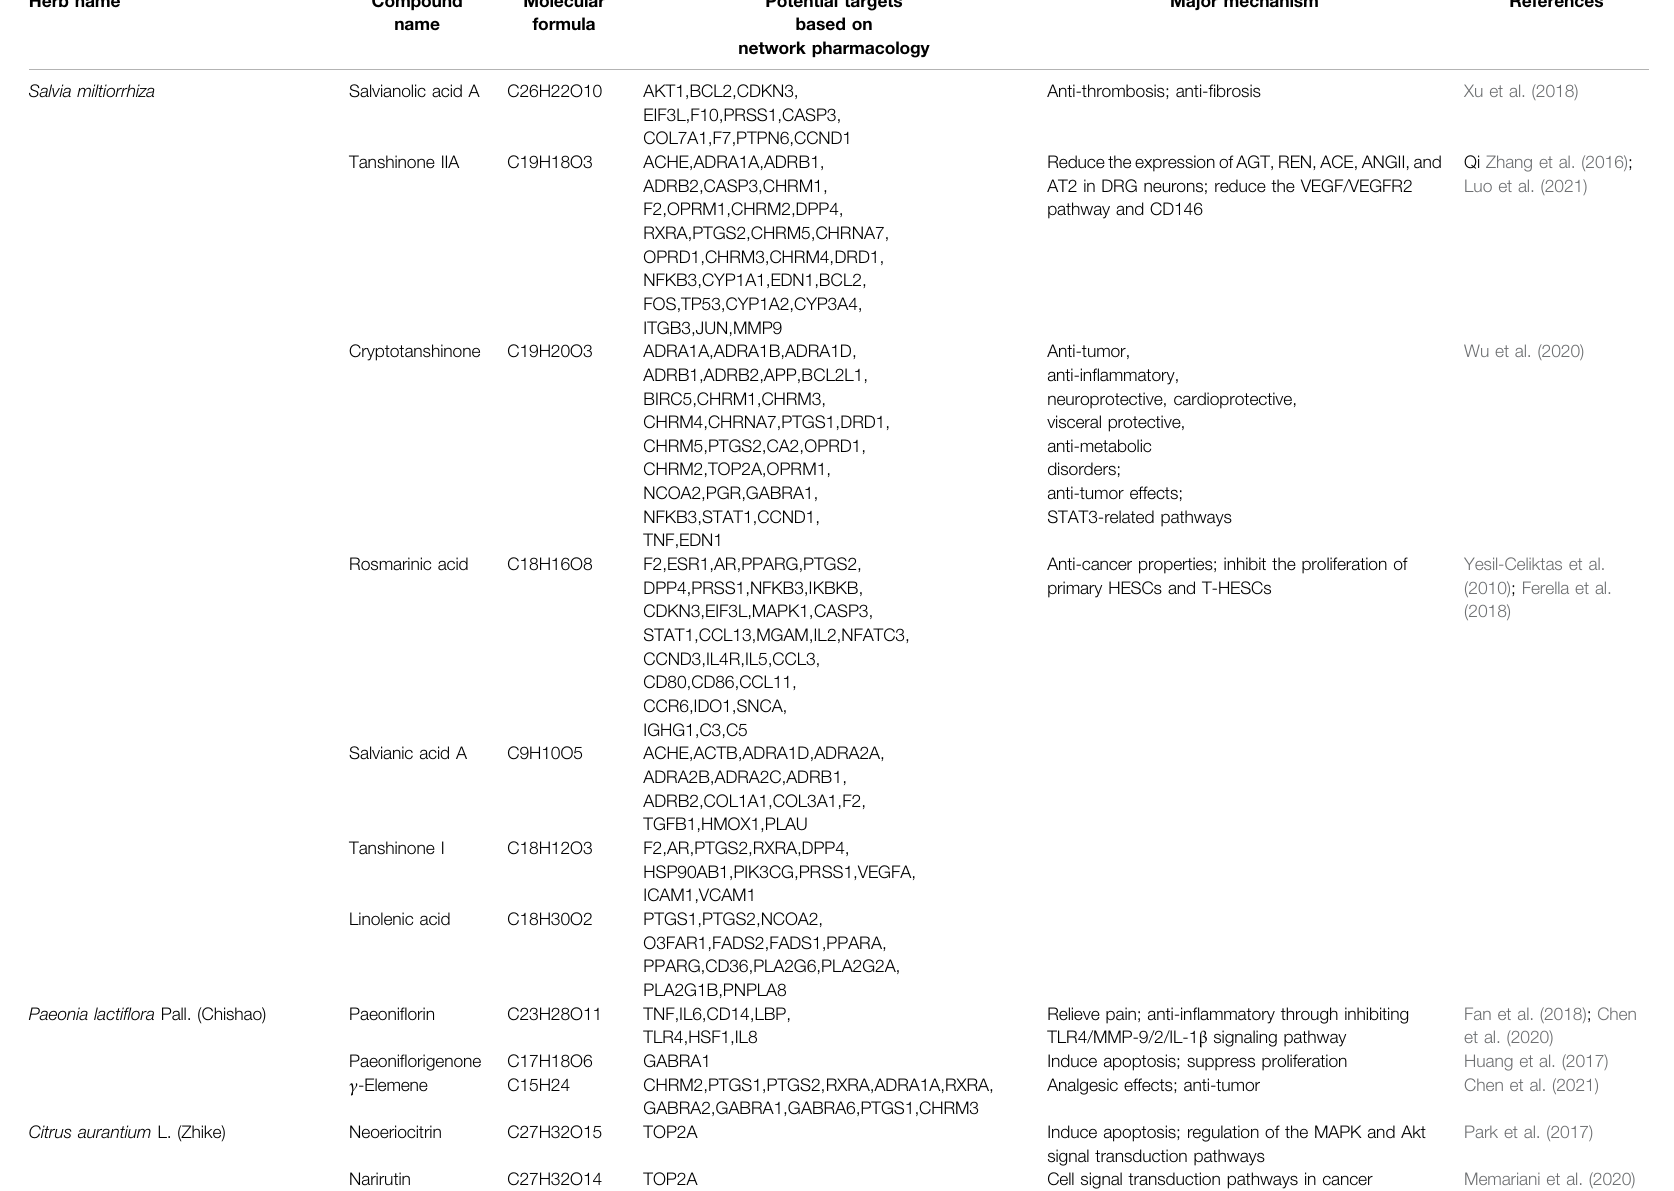
TABLE 3 | Mechanism of the compounds with potential therapeutic